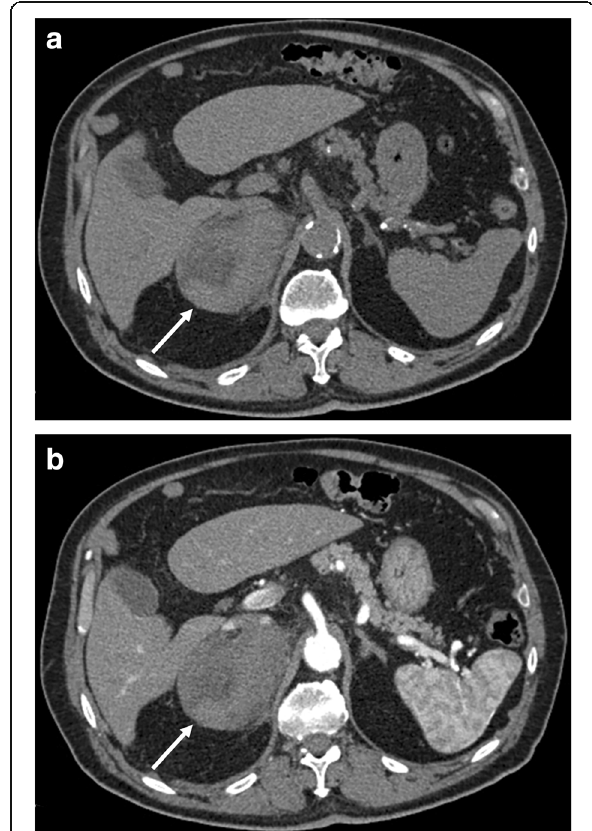
Fig. 3 Right adrenal hemorrhage in a 61-year-old man with acute abdominal pain after starting anticoagulant therapy.